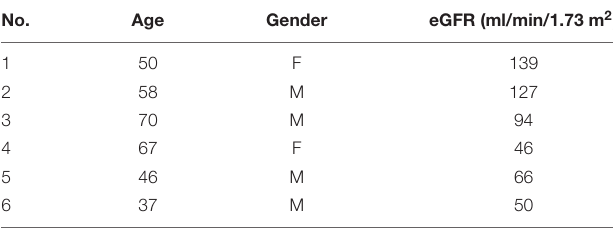
eGFR, estimated glomerular filtration rate based on the CKD-EPI formula. Cases 1–3, normal control kidney tissue from patients with a kidney tumor. Cases 4–6, renal biopsies from patients with chronic tubulointerstitial nephritis.